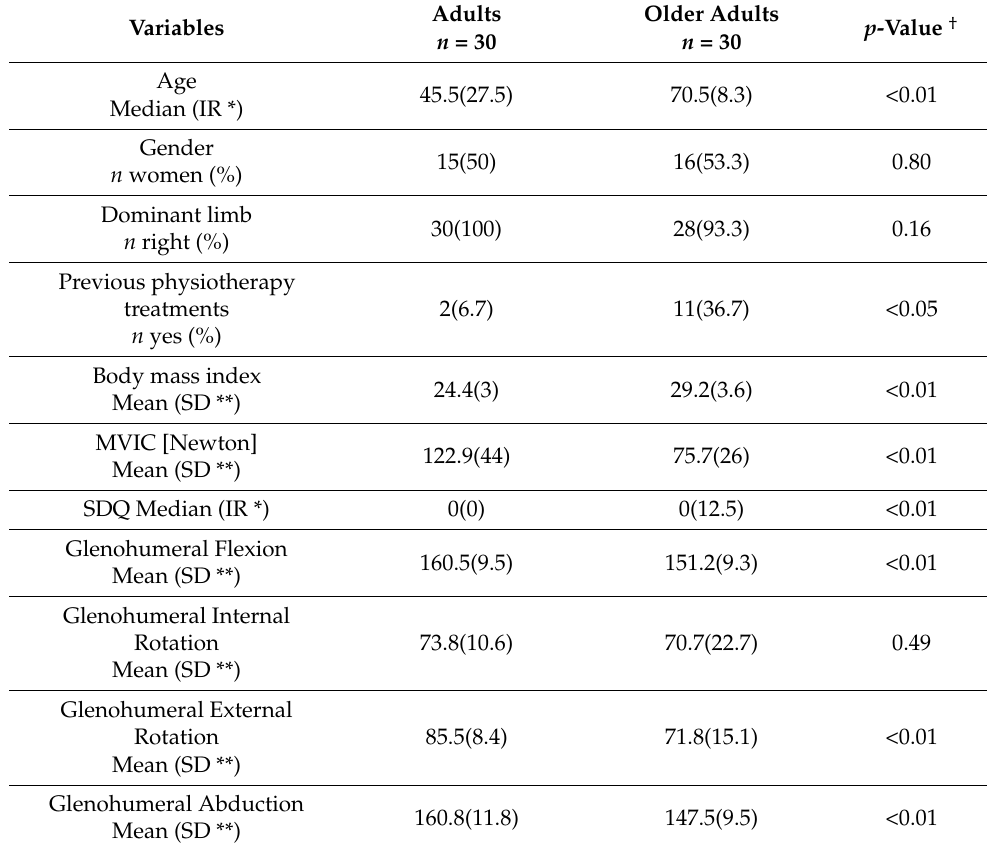
Table 1. Demographic and clinical